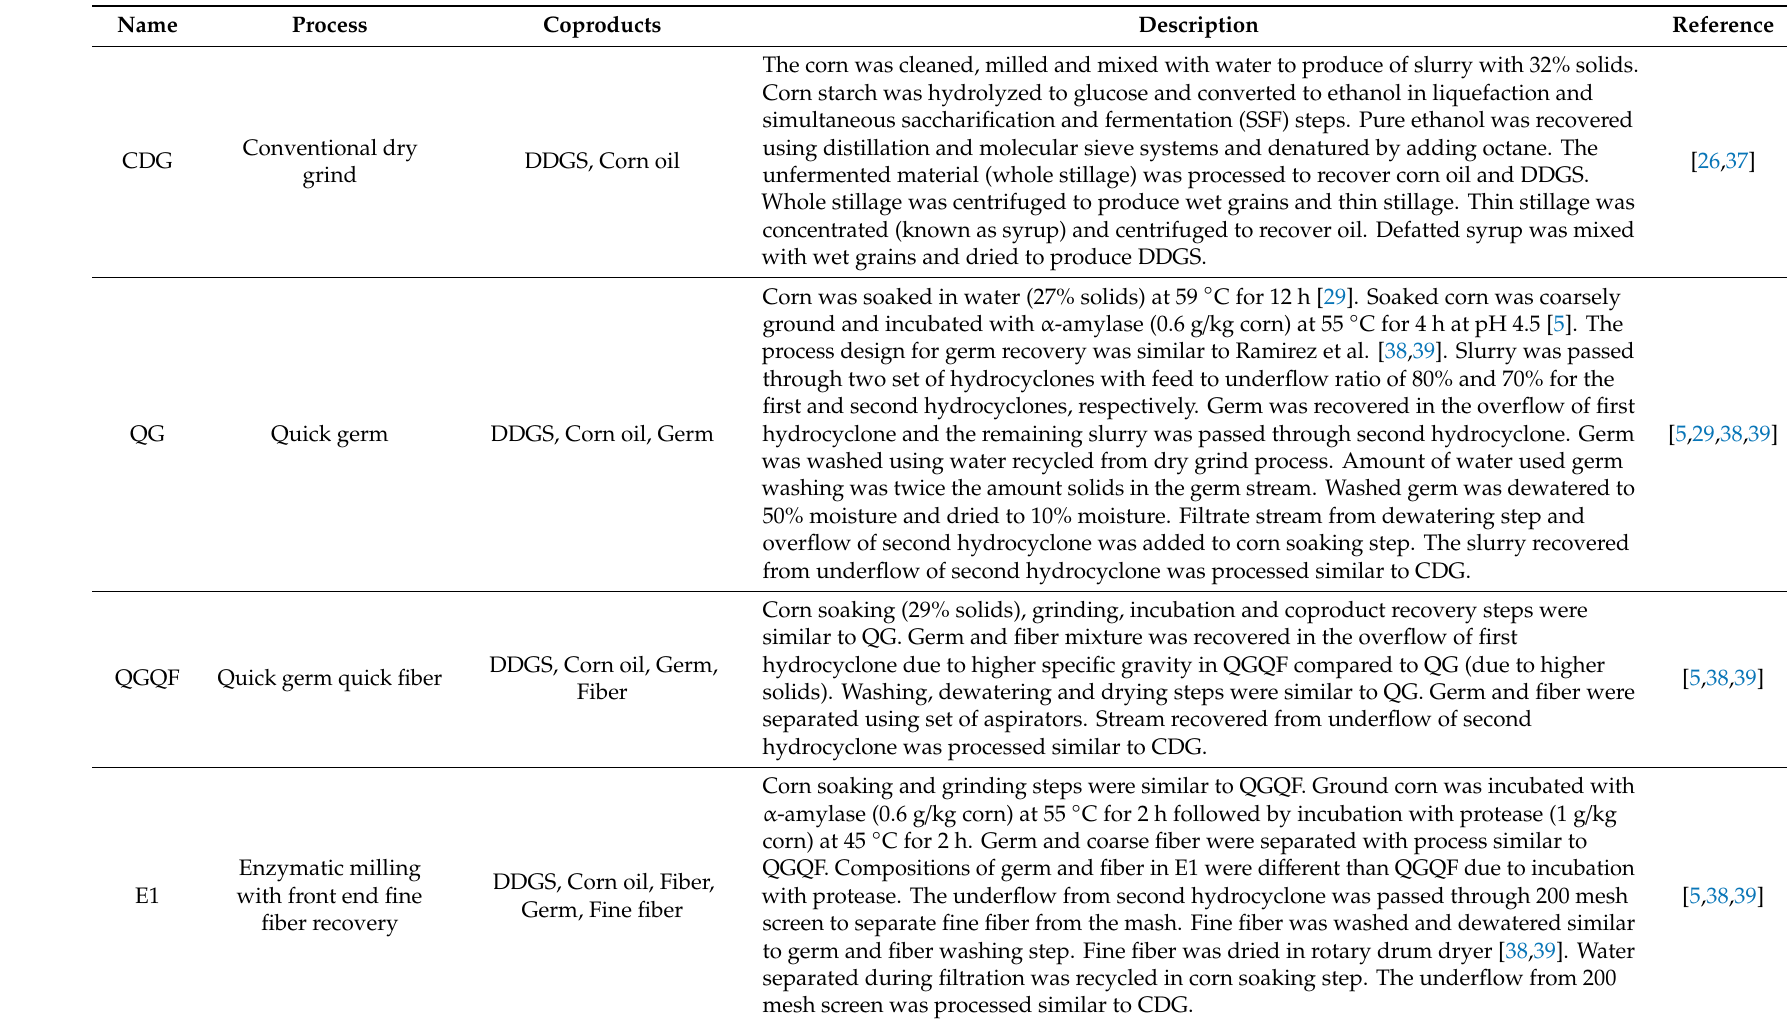
Table 1. Summary of conventional dry grind process and wet fractionation